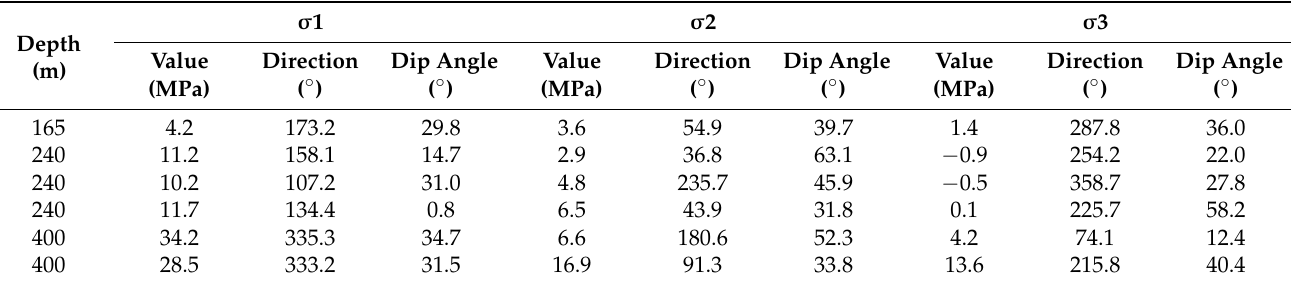
Table 1. Ground stresses in the study